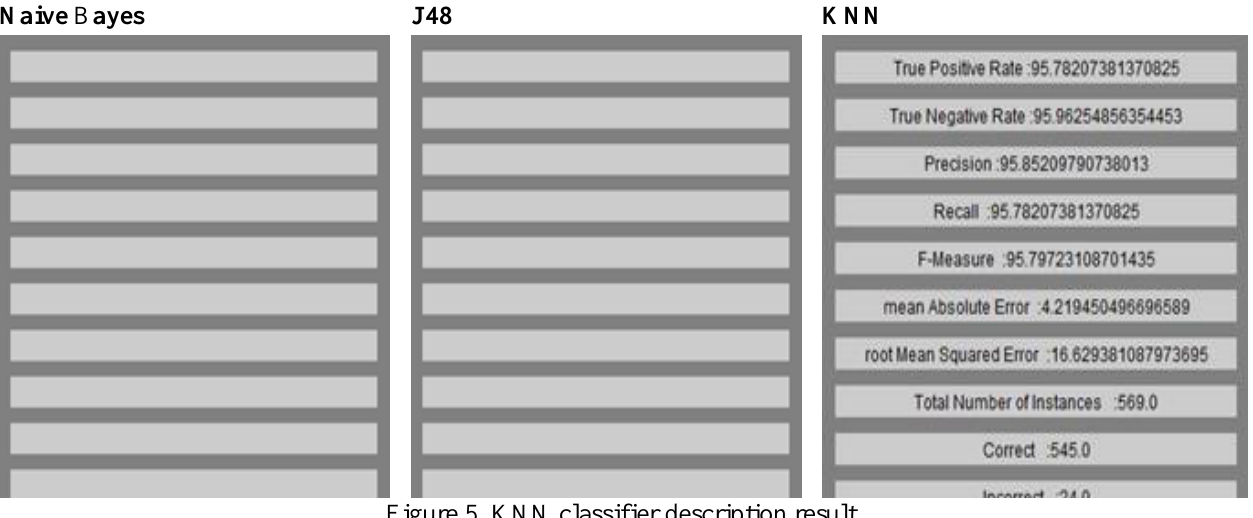
Figure 5. KNN classifier description